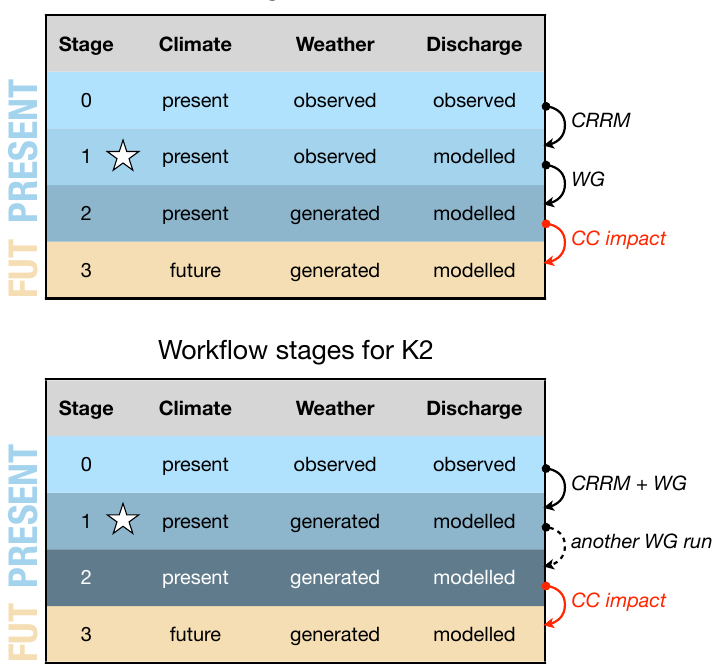
Figure 3. Scheme of workflow stages for different uncertainty assessment approaches. White stars indicate the stages where the parameters of the hydrological model were calibrated. “Climate” specifies the distribution of climatic parameters (“present”/“future”) and “Weather” tells whether the actual weather data are observed or generated. WG: weather generator; CC: climate